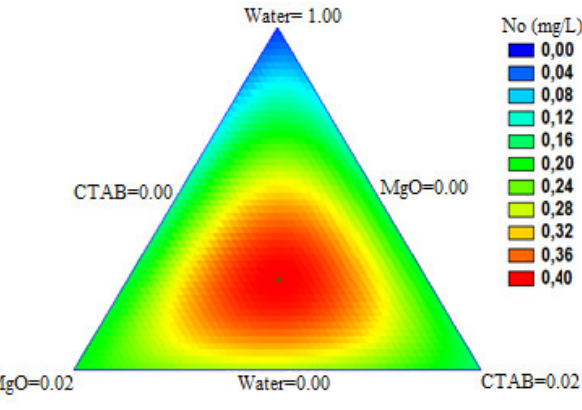
Figure 12. Response surface for the three compounds evaluated (MgO nanoparticles, CTAB, deionized water) obtaining the N 0 (mg · L − 1 ) parameter according to the cubic special model of the simplex-centroid mixtures design of experiments.